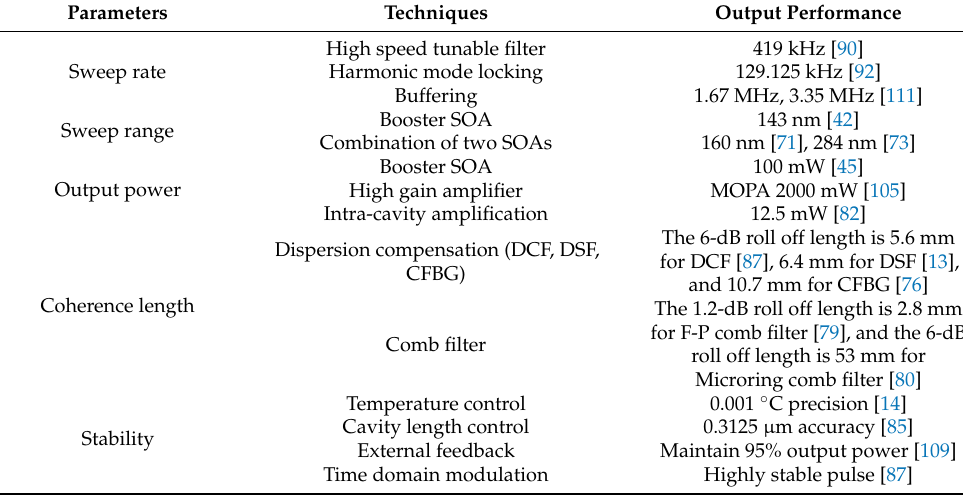
Table 1. Summary of FDML parameters with different kinds of